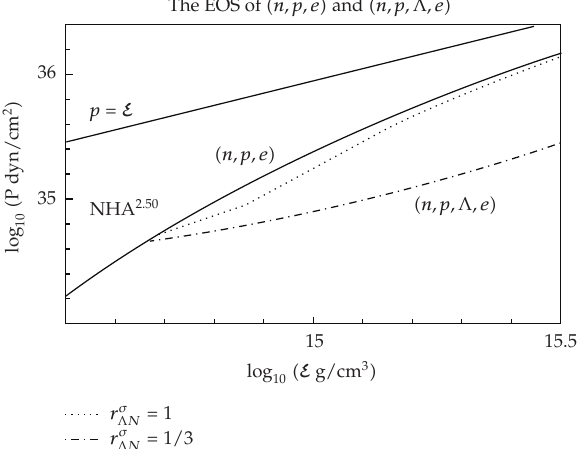
(cid:5) 1 / 3 becomes softer in N